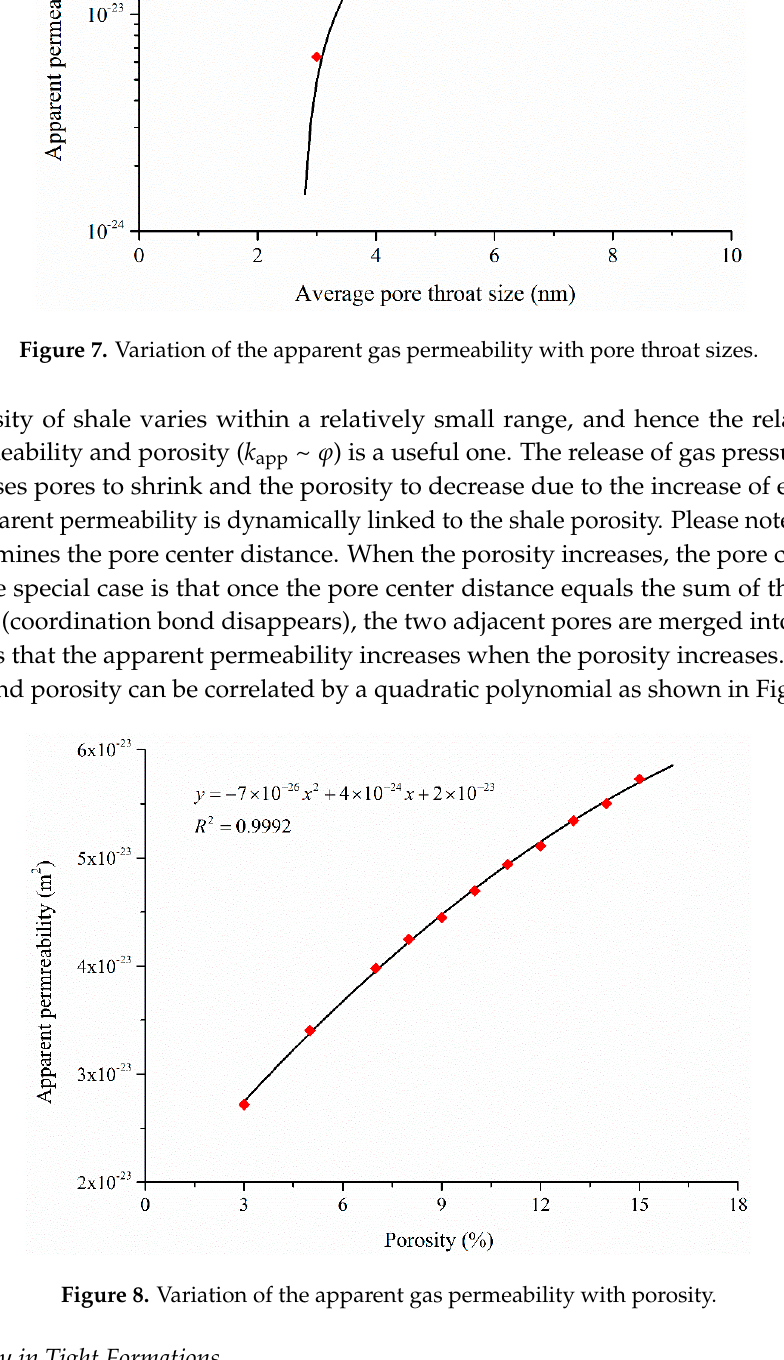
Figure 6. Variation of the apparent gas permeability with reservoir gas pressures.